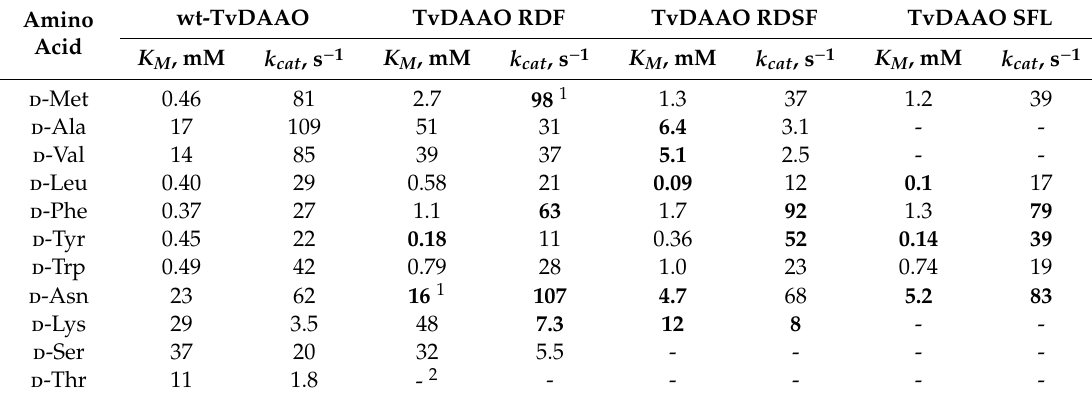
Table A1. Kinetic parameters of wt-TvDAAO, TvDAAO RDF, TvDAAO RDSF and TvDAAO SFL